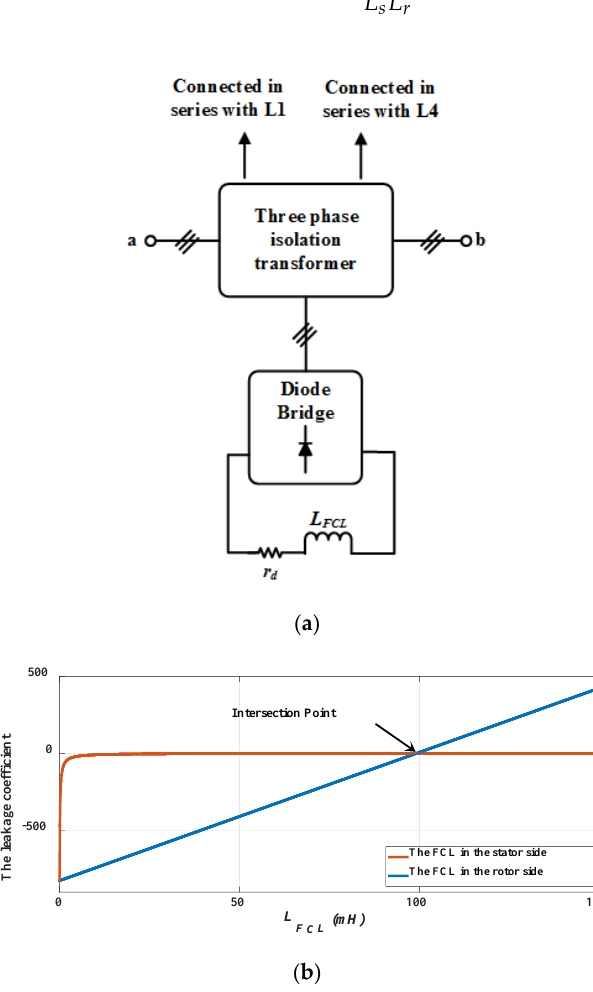
Figure 5. ( a ) The non-controlled inductive fault current limiter [26]; and ( b ) the leakage coefficient variation, with the FCL inductance variation in the stator and the rotor